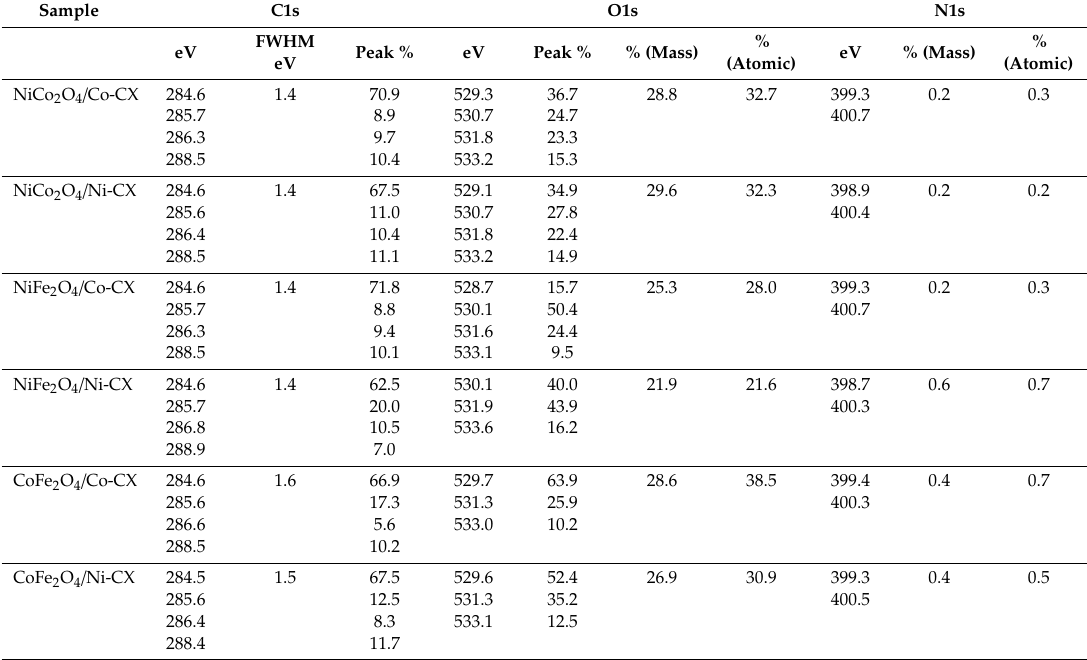
Table 3. Binding energies and chemical composition of C1s, O1s, and